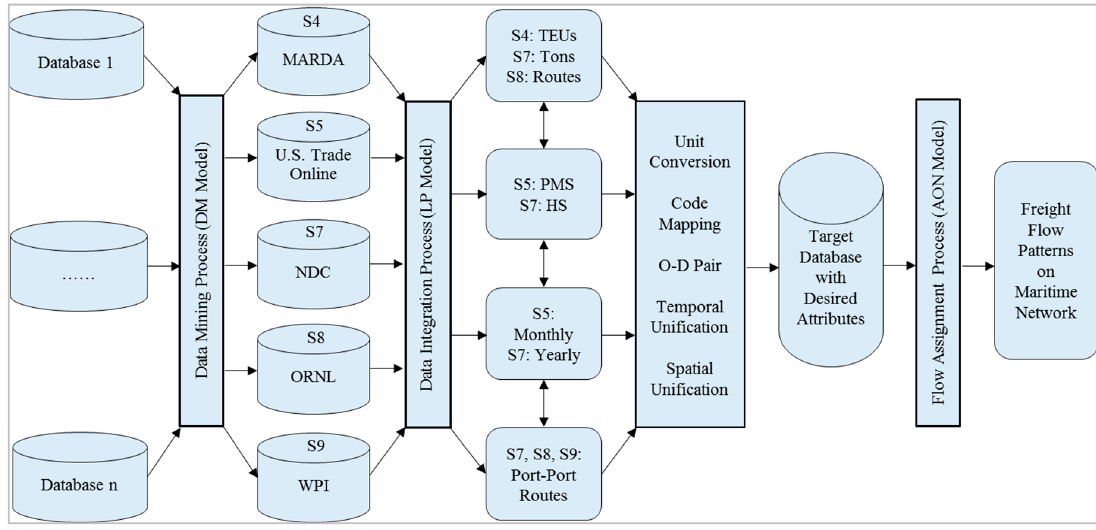
Figure 3. Modelling and data processing chart.